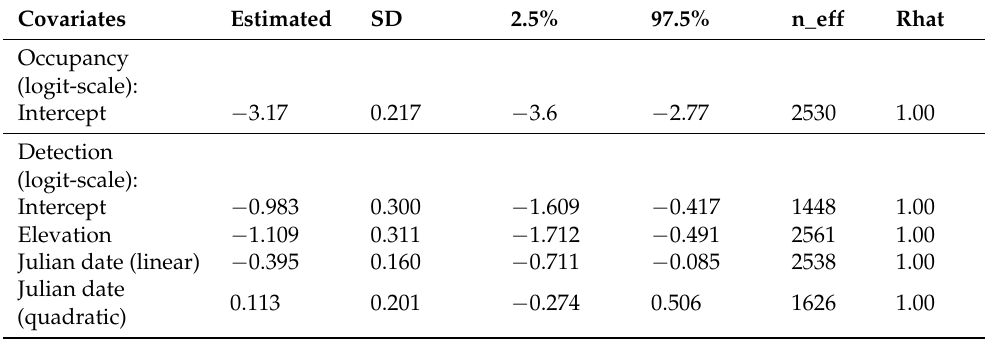
Table A10. Output summary from the best spatial occupancy model ( ψ (intercept + elevation + precipita- dog ( Canis lupus familiaris ) in Puerto Rico. Note: fa2 = proportion of forest cover aged between 32 and